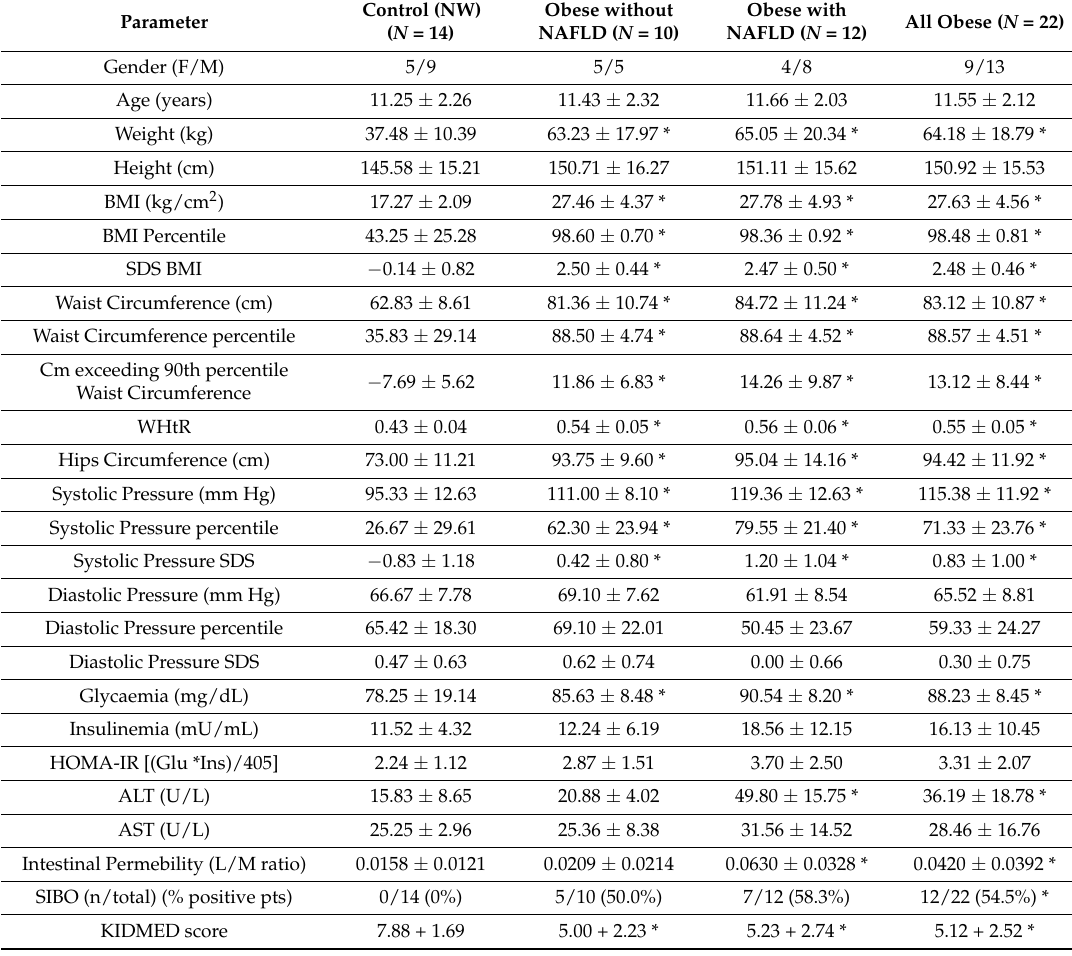
Table 1. Characteristics of the study